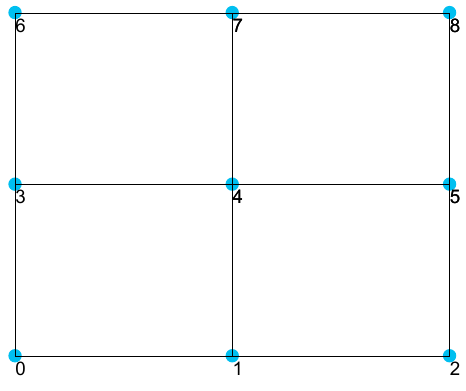
Figure 5. 3 × 3 lattice converter (4. 4. 4. 4).